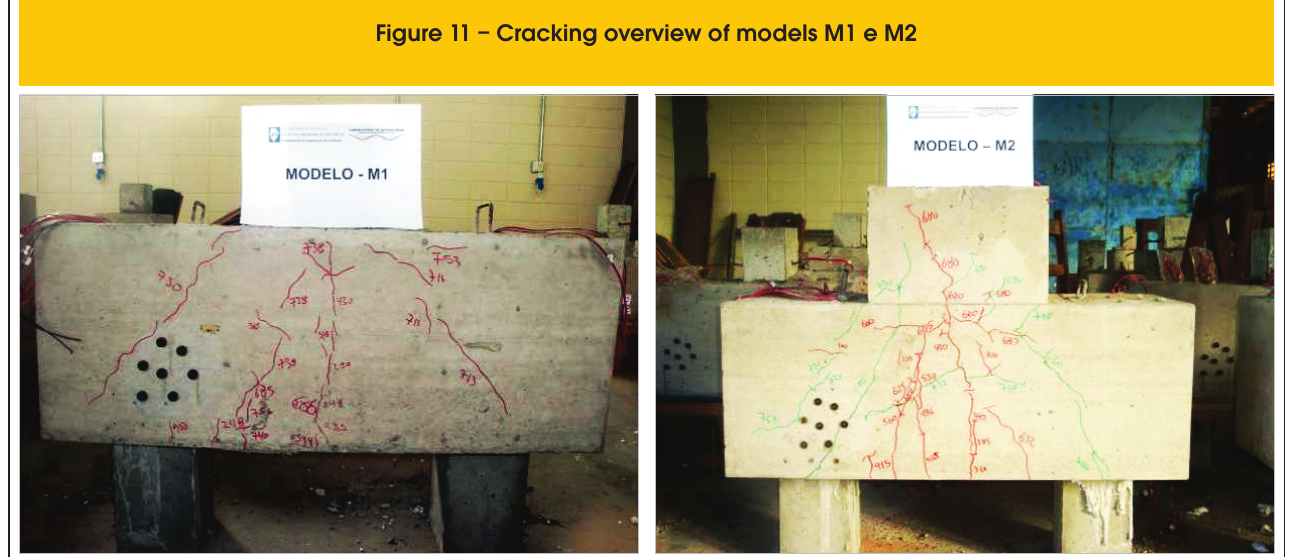
Figure 11 – Cracking overview of models M1 e M2